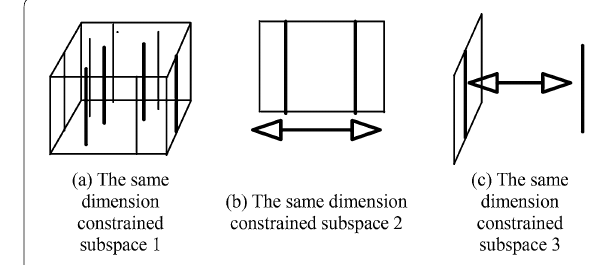
Figure 16 The same dimension constrained